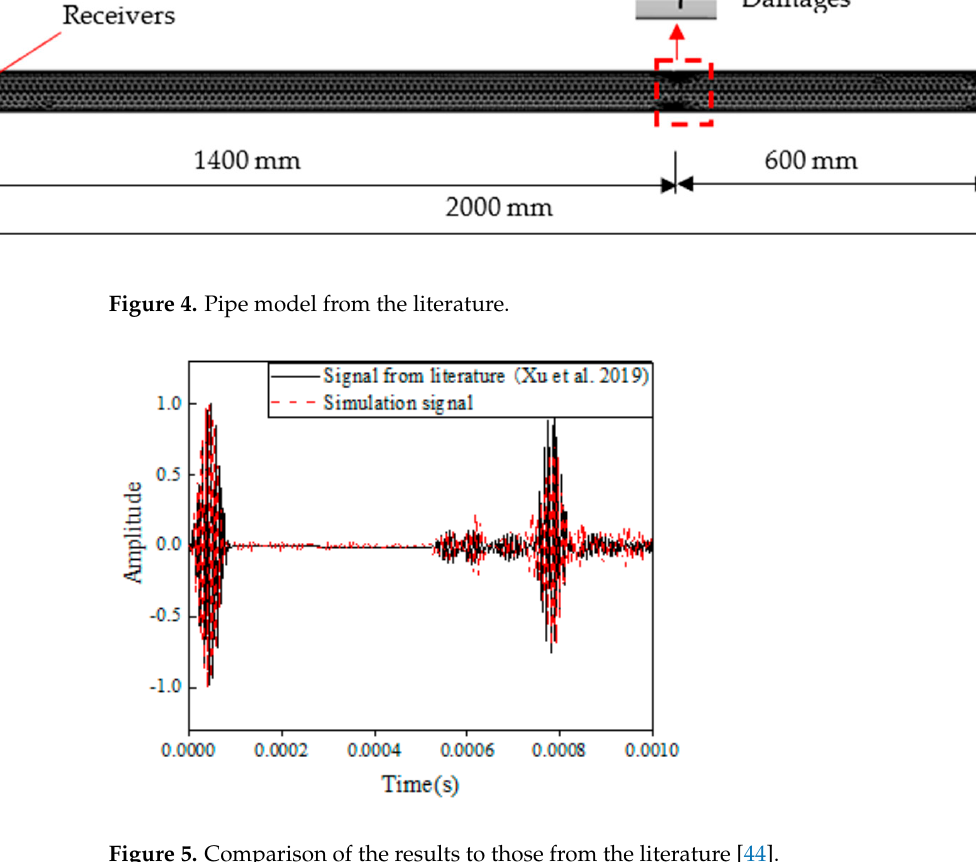
Figure 5. Comparison of the results to those from the literature [44].